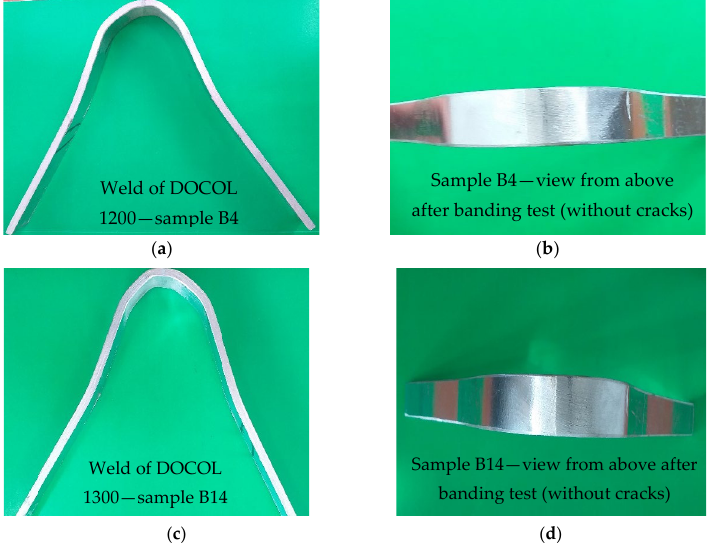
Figure 2. Samples after banding tests: ( a , b ) weld of DOCOL 1200; ( c , d ) weld of DOCOL 1300.